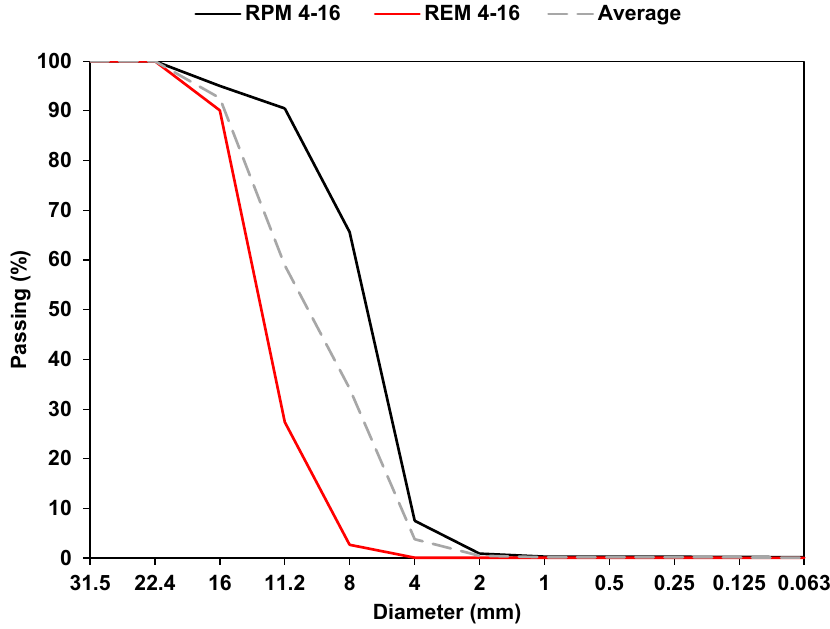
Figure 1. Grain size distribution curves for REM and RPM.